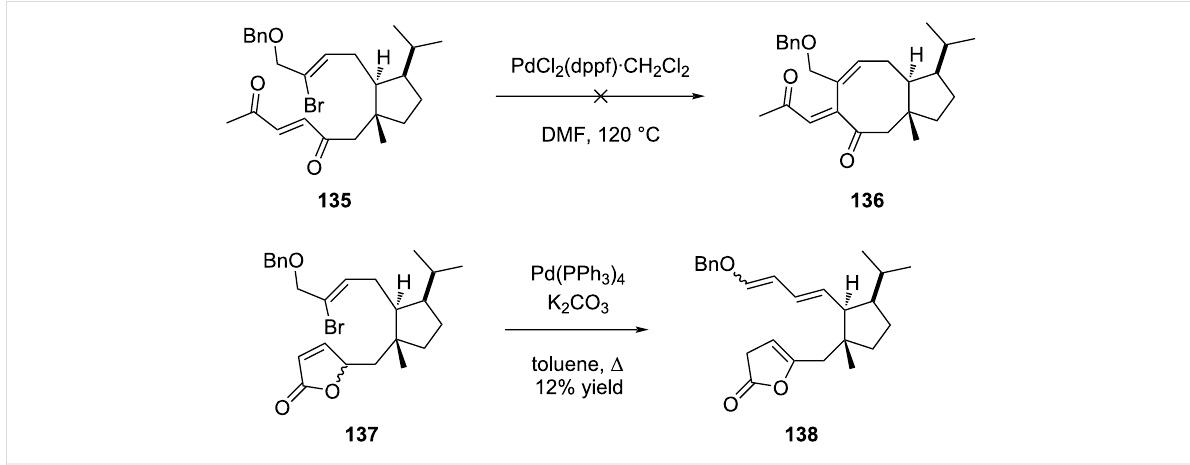
Scheme 27: Influence of the replacement of the allylic alcohol